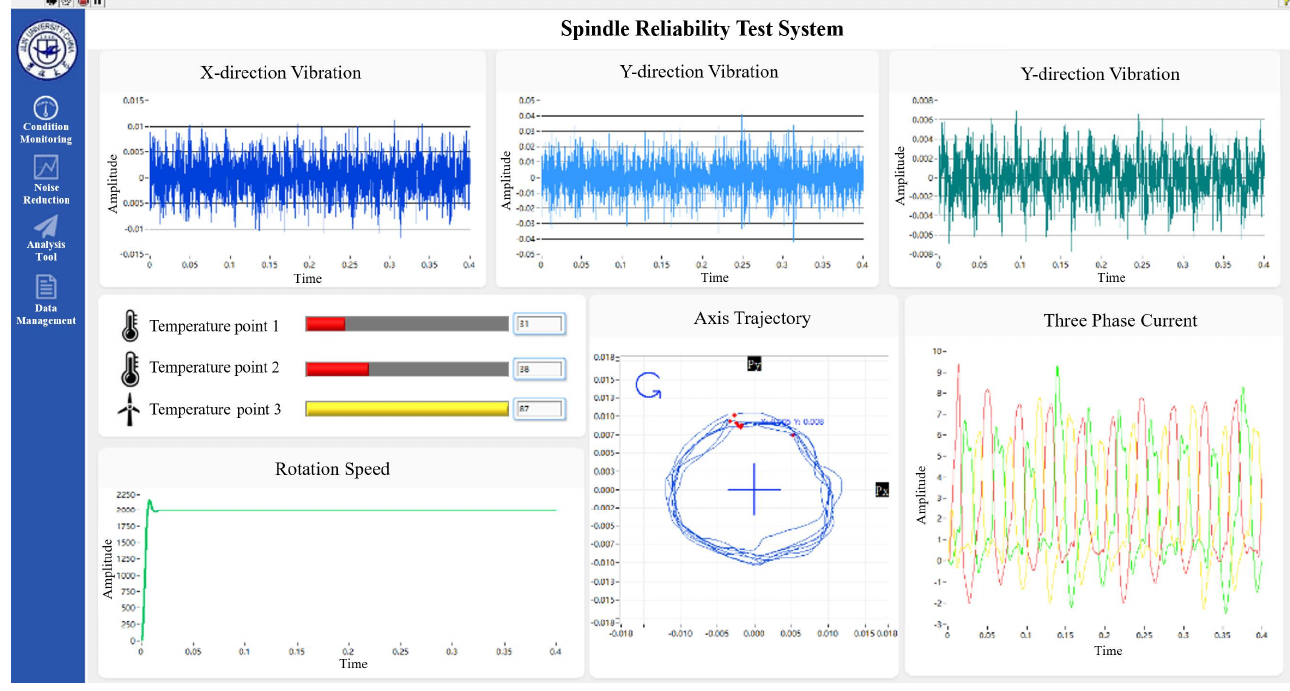
Figure 19. Reliability test results of